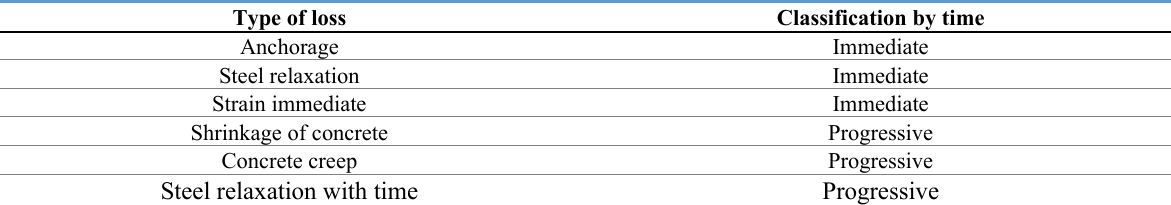
Table 1. Prestressing